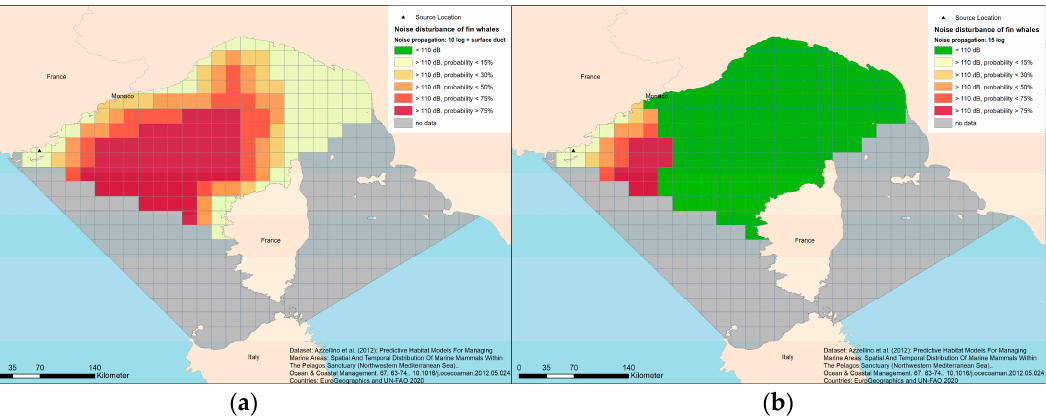
Figure 15. Potentially usable habitat probability for cetaceans exposed due to an airgun array (ESL =186 dB re 1 µPa 2 m 2 s) event, with an exposure threshold 110 dB in using a 15-log law in ( b ), and a 10 log with a surface duct in ( a ).